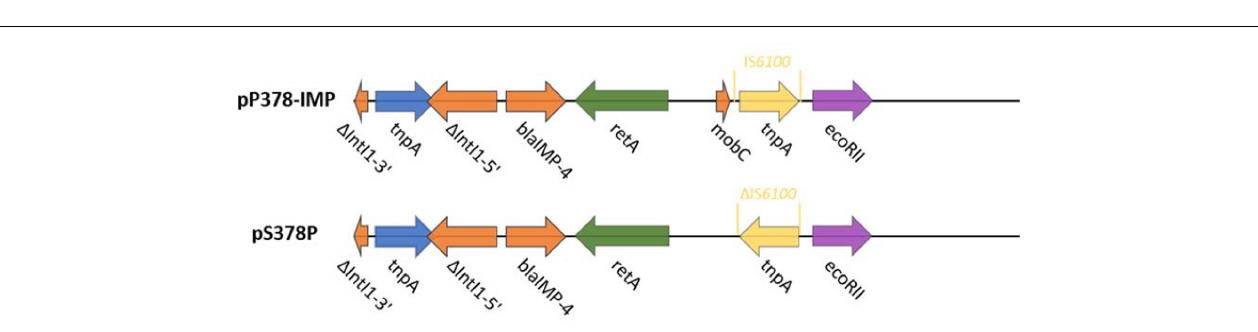
FIGURE 1 | Circular comparison between plasmid pS378P (MZ643942, in this study) and plasmid pP378-IMP (KX711879). The different colors indicated different plasmids and are listed in the color key.